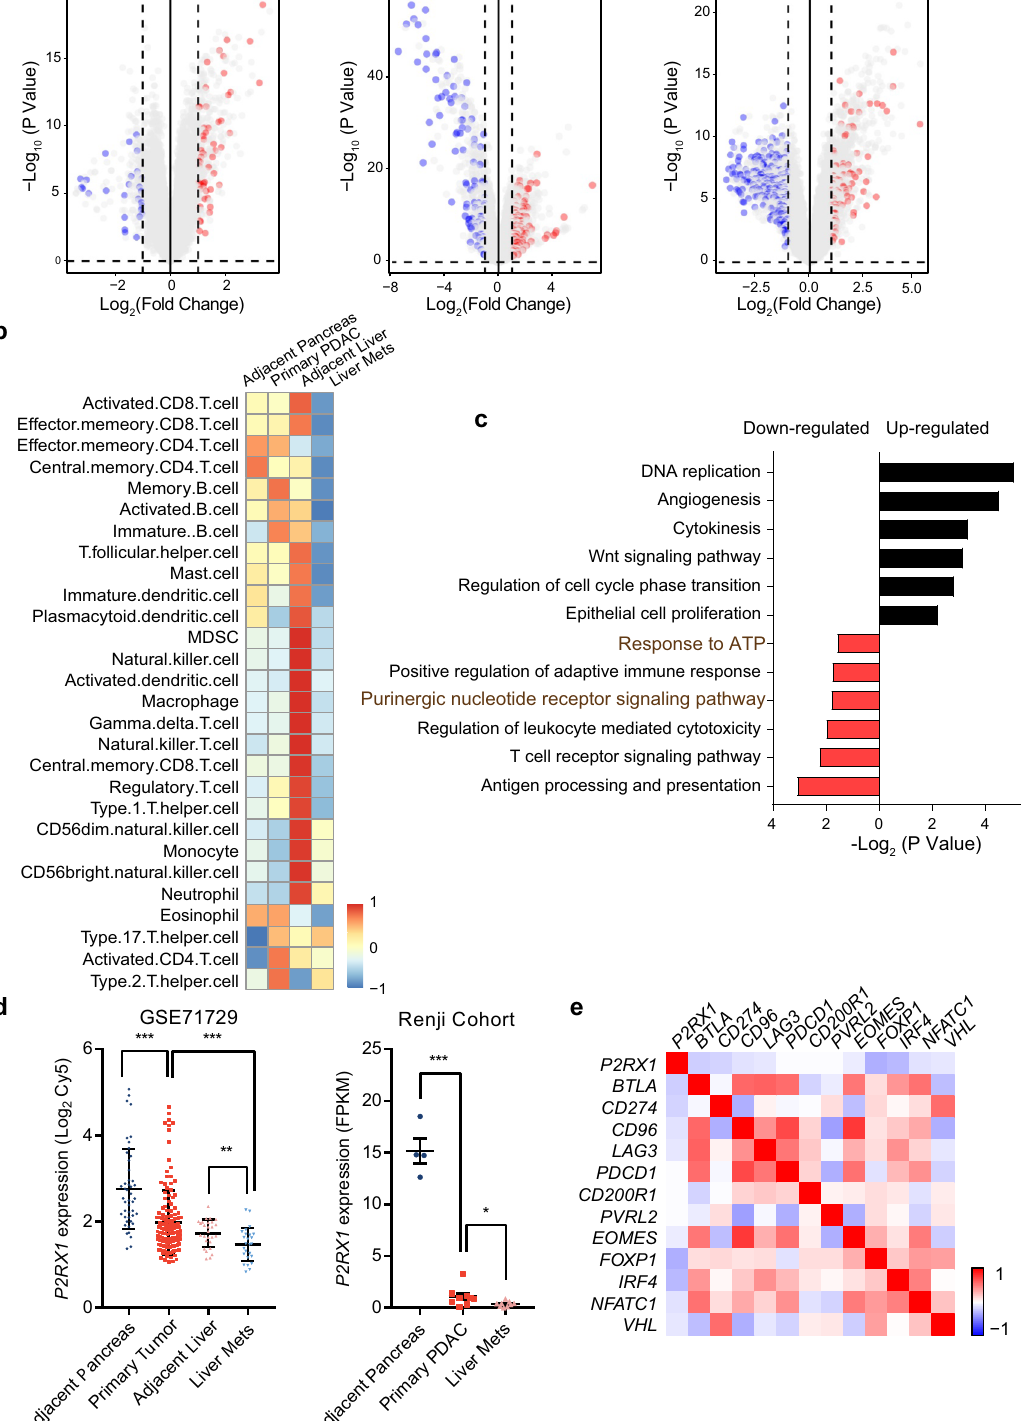
(Fig. 1d). These results indicated that reduced P2RX1 in PDAC